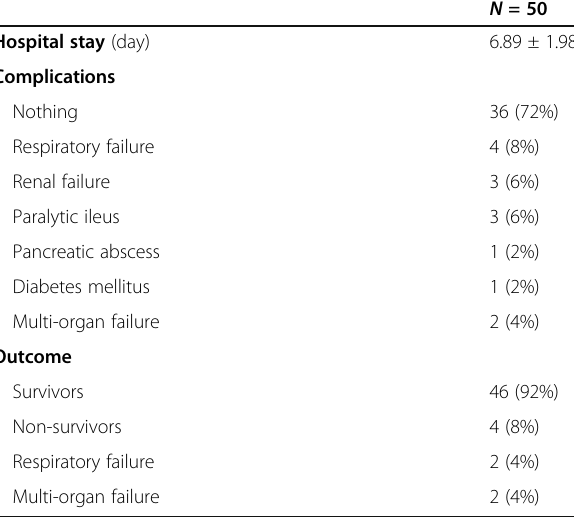
Table 3 Hospital stay and outcome in studied patients